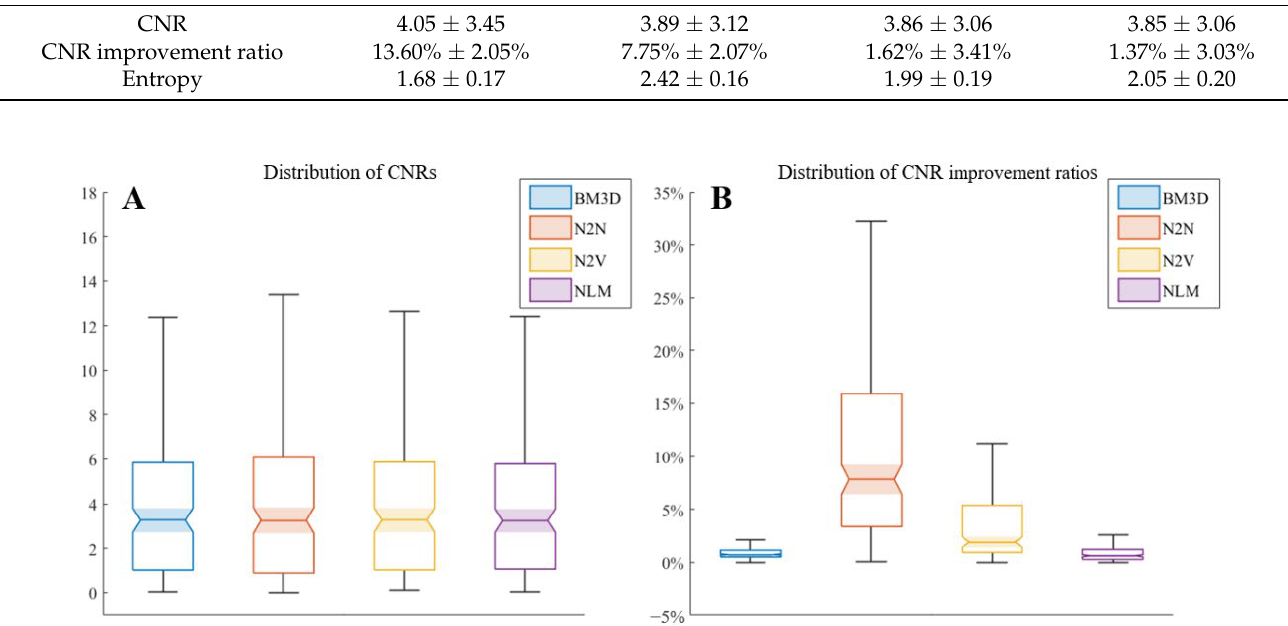
Figure 4. Distributions of CNRs ( A ) and CNR improvement ratios ( B ) for the results of BM3D, N2N, N2V and NLM. Table 3. Values of CNRs, CNR improvement ratios and entropy presented by N2N, N2V, BM3D and NLM.